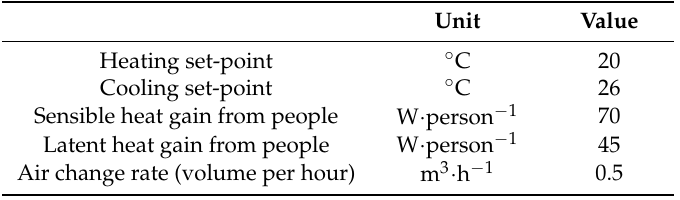
Table 3. EnergyPlus boundary condition data for the case study’s building.